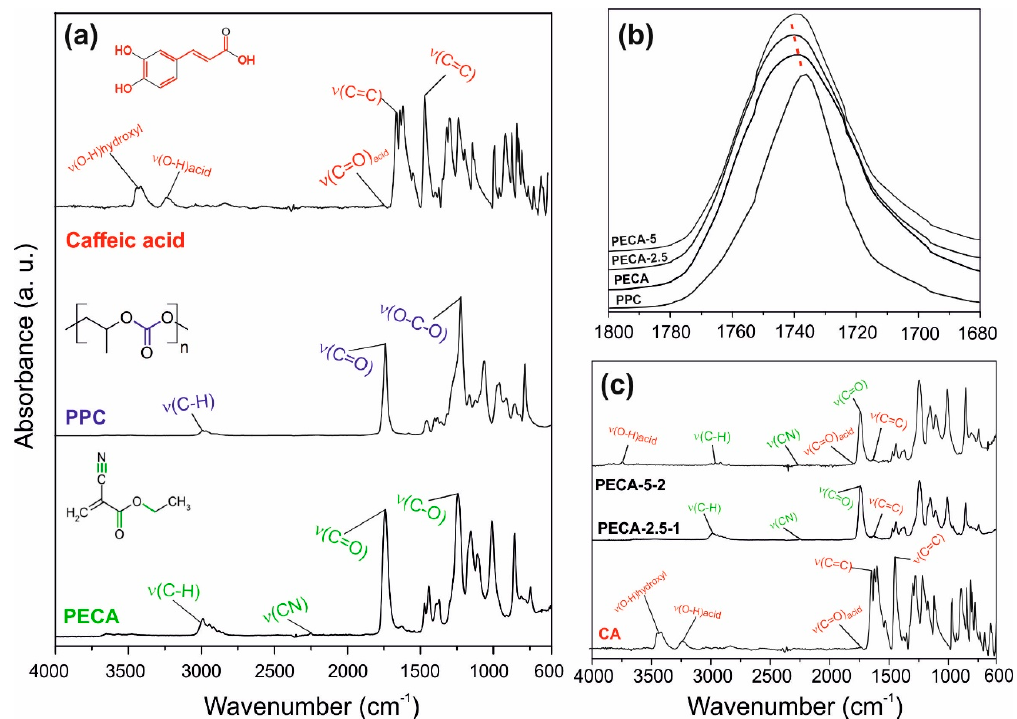
Figure 5. ( a ) The molecular structure and the infrared spectra of the pristine PECA, PPC, and caffeic acid covering the wavelength region 4000–600 cm − 1 . The characteristic peaks of PECA, PPC, and caffeic acid are indicated on each compound spectrum. ( b ) Stretching vibration band of ν (C = O) bonds belonged to pristine PECA, PPC, and PECA–PPC blends (PECA-2.5 and PECA-5). ( c ) The infrared spectra of PECA-2.5-1, PECA-5-2, and caffeic acid, with the characteristic peaks assigned, in the region 4000–600 cm − 1 .